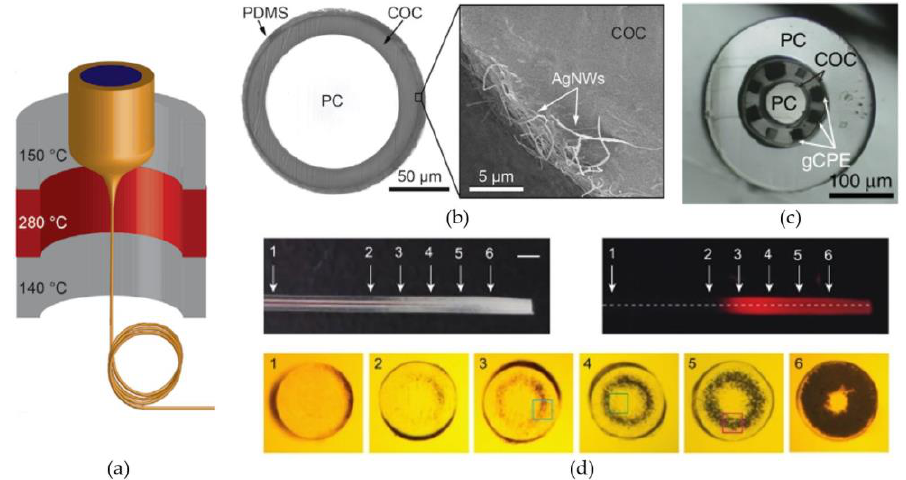
Figure 5. Optical fibers and fiber-based optrodes manufactured with thermoplastic polymers. ( a ) Thermal drawing of the PC/COC preform to obtain small optical fibers. ( b ) A cross-section of the PC/COC fiber after coating with AgNWs and PDMS. The SEM image depicts a close-up view of the AgNW electrode. Reproduced with permission from [137]; published by AAAS, 2017. ( c ) A cross-section of the multifunctional fiber presented by Park et al. [138], containing six incorporated graphite-conductive polyethylene (gCPE) electrodes and two microfluidic channels. Reproduced with permission from [138]; published by Springer Nature, 2017. ( d ) Photographs of the thermally drawn PES fiber after localized heat treatment. The amount of induced scattering centers is gradually increased from position 1 to position 6. For each position, the corresponding cross-section is given. The dark spots present in the cross-sections correspond to the induced microbubbles. Reprinted with permission from [142] © The Optical Society.